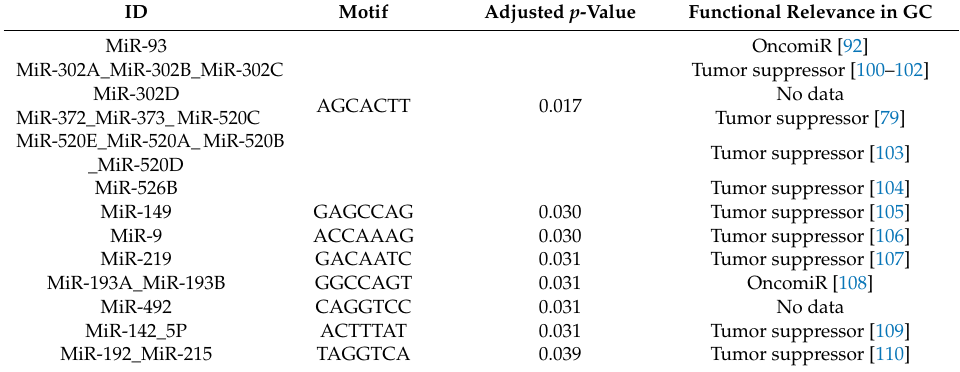
Table 3. List of downregulated miRNAs in gastric cancer stem cell. Adjusted p -value < 0.05 was considered as statistically significant.